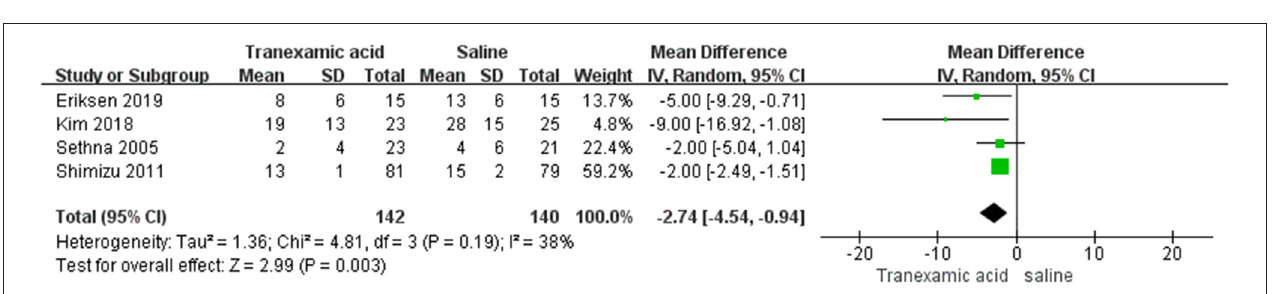
FIGURE 7 | Meta-analysis of intraoperative FFP transfusion for TXA compared with